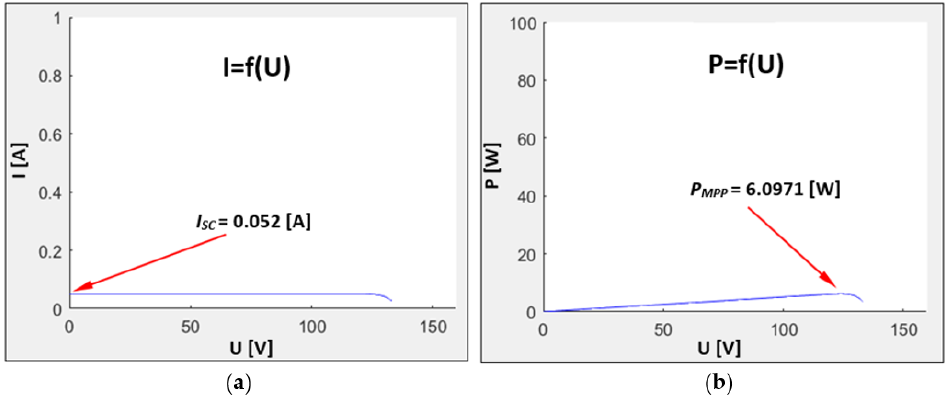
Figure 9. Simulation results for irradiance of 300 W/m 2 deflected by an angle Δ θ = 5° from the direction of perpendicular incidence and a temperature of 21 °C for the modeled CX-75/200 module: